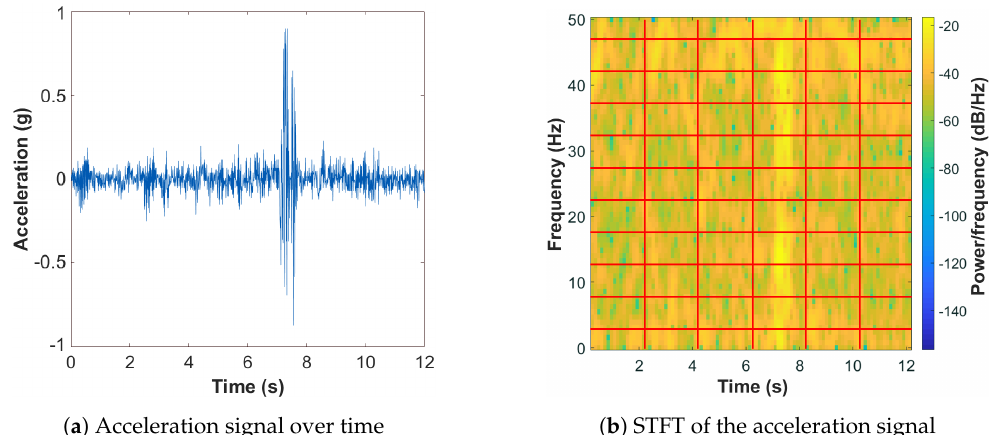
Figure 3. Example of high-pass filtered acceleration signal perpendicular to the road surface acquired during a period of 12 s ( a ) and of the magnitude of its STFT ( b